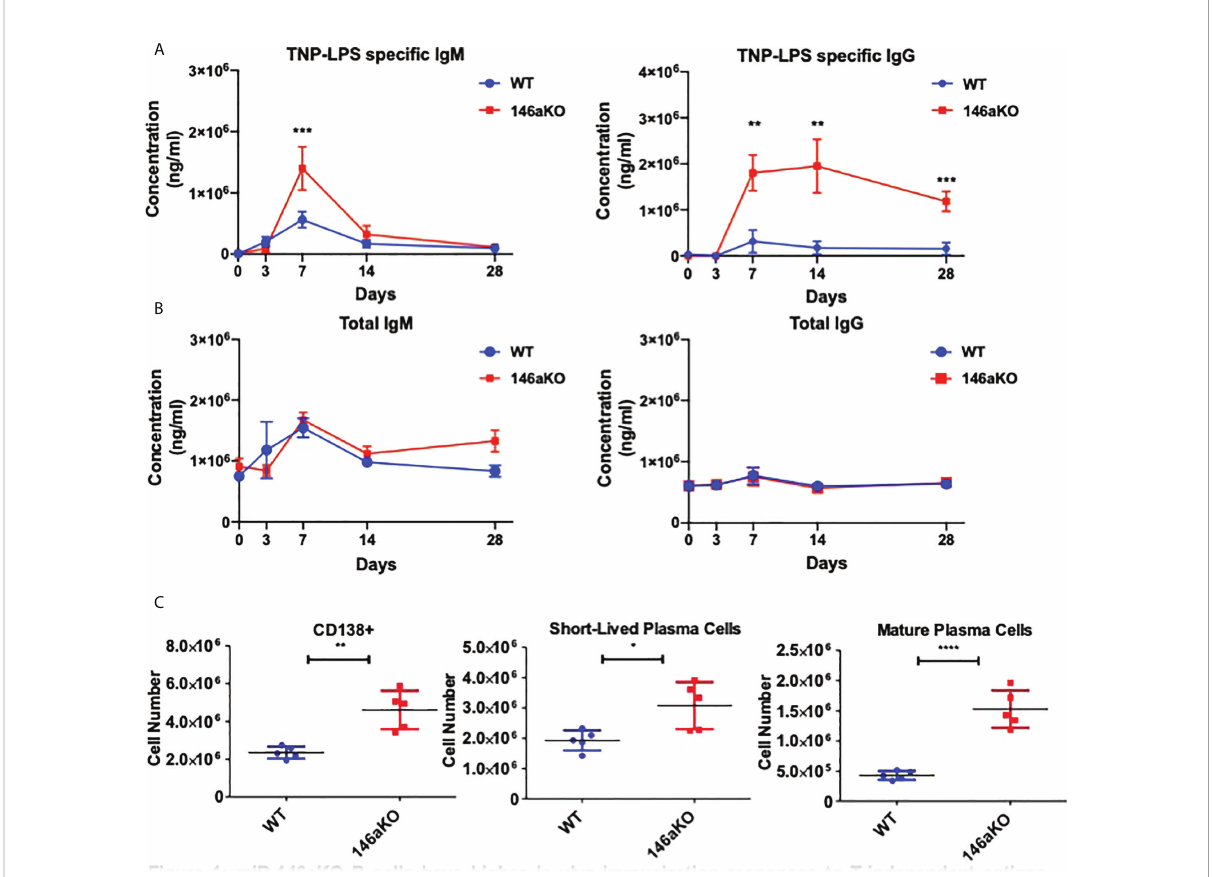
FIGURE 1 miR-146aKO B cells have higher in vivo immunization responses to T-independent antigen than WT. (A) Primary immunization antibody response to T- independent antigen at day 28 show TNP-LPS speci fi c antibodies vs . (B) total IgM, IgG antibodies. (C) FACS analysis of plasma cells and subsets at endpoint. n = 6-9 mice/group. All analysis used t test for respective time point comparisons; * P < 0.05, ** P < 0.01, *** P < 0.001, **** P < 0.0001. Data represent mean ±